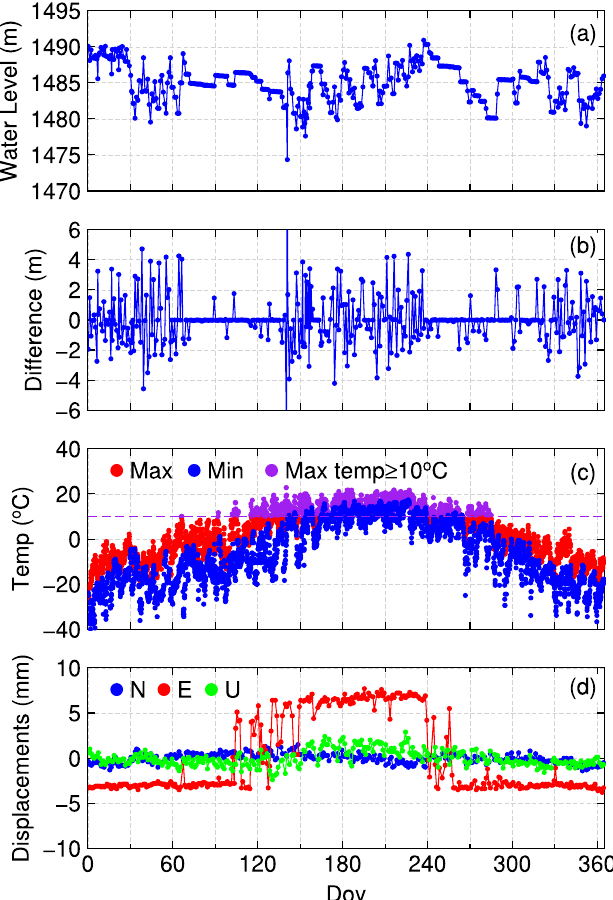
Figure 8. Water level data ( a ), water data daily difference ( b ), temperature data ( c ) and the baseline times series in 2013 ( d ). Maximum temperature data larger than 10 °C are shown in purple.